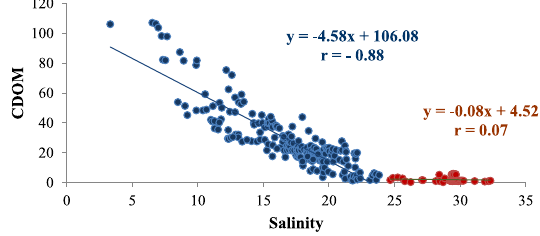
Figure 3. The relationship between the salinity and CDOM (QSU) in the inner and middle ESAS surface water in August– September 2003, 2004, 2005, 2008, and 2011 (blue circles: salin- ity < 24.5; red: >